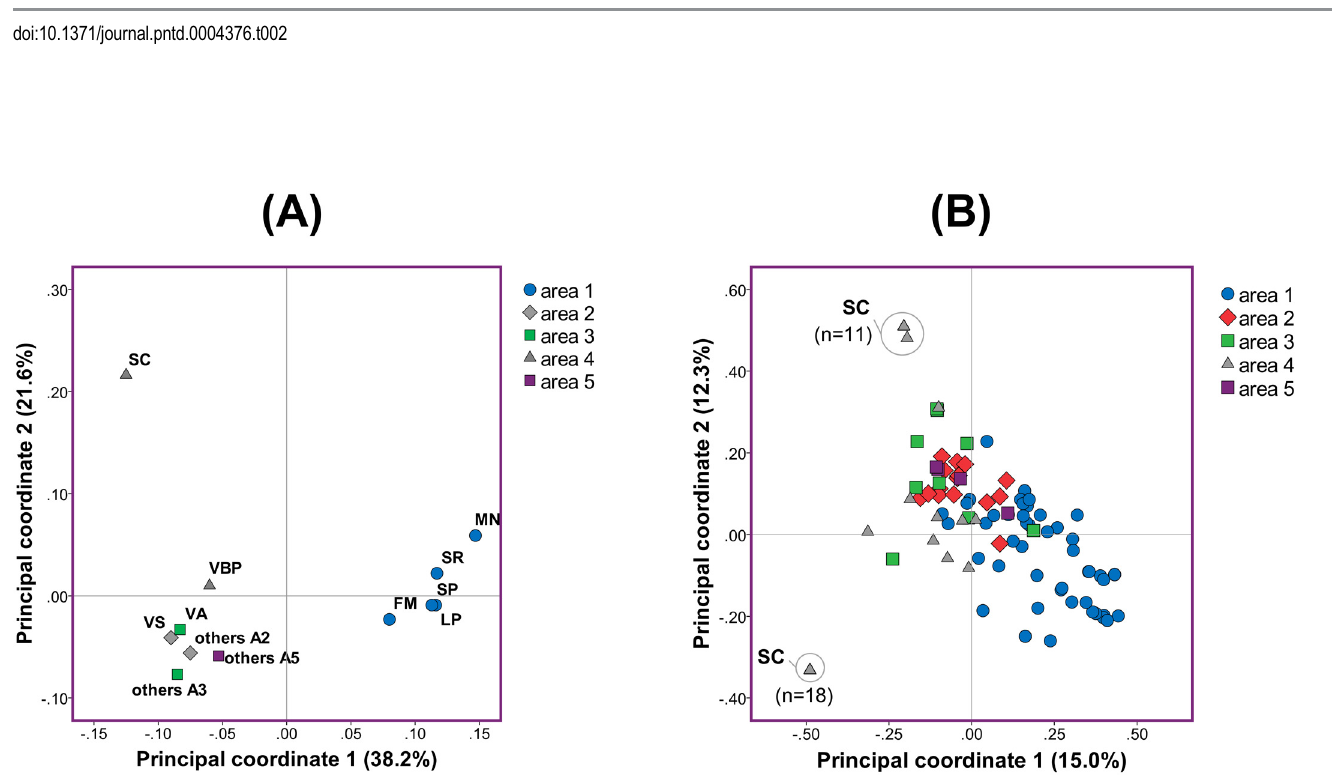
fi cantly greater than 0 at the 5% signi fi cance level. Areas (A1, A2 ... ) are de fi ned in Fig 1A and villages abbreviations PHI PT values given in bold were signi are detailed in S1 Table.